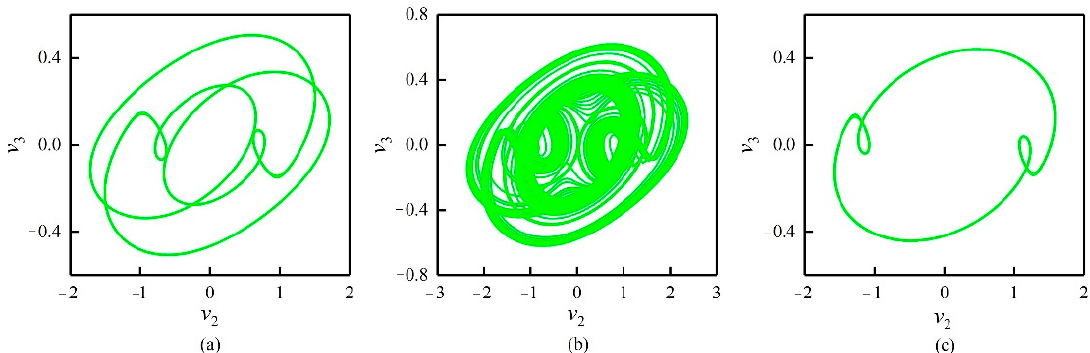
Figure 6. Attractor trajectories with q = 0.8, β 2 = 12, ( a ) β 1 = − 0.05, ( b ) β 1 = 0.3 ( c ) q = 0.82. When fixing the parameters β 1 = 0.2, q = 0.8, h = 0.01, and β 2 ∈ (6, 20), the FOHNN system appears to have more complex characteristics of the dynamics. Furthermore, the Lyapunov exponential spectrum of the system, the bifurcation diagram, Lyapunov dimension diagram, are presented and plotted in Figure 7. The phase diagrams of the different types of attractors are drawn in Figure 8. When β 2 ∈ (6, 8.65), the system generates